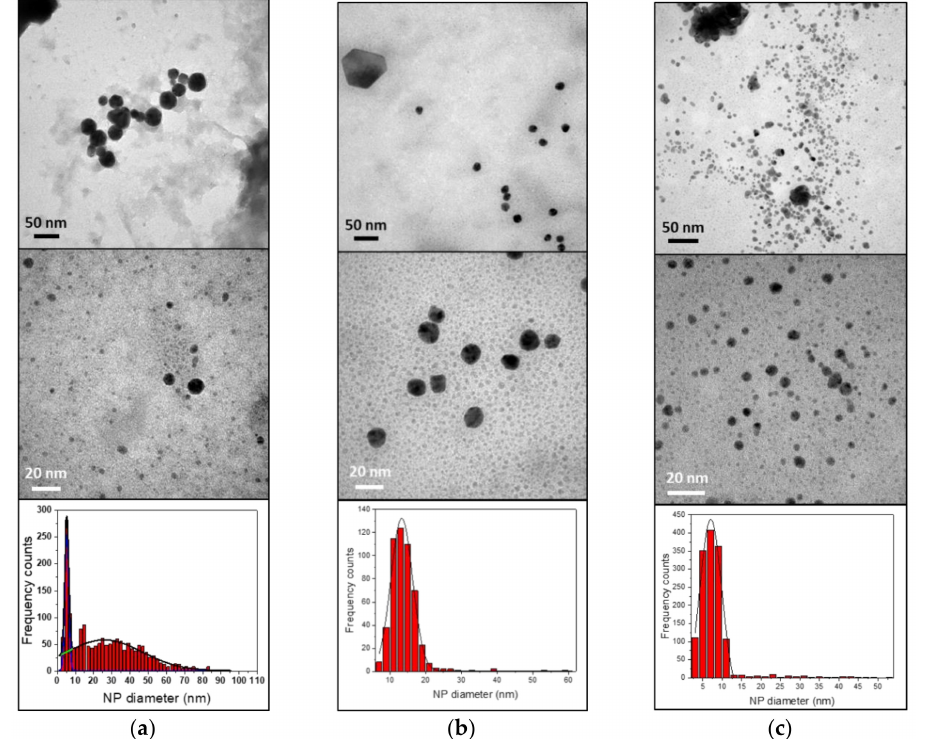
Figure 5. TEM images and corresponding size distribution histograms of AuNPs synthesized using di ff erent stainless steels: ( a ) AISI 430; ( b ) AISI 410; ( c ) AISI 304. TEM micrographs of all samples show spheroidal nanoparticles (Figure 5).